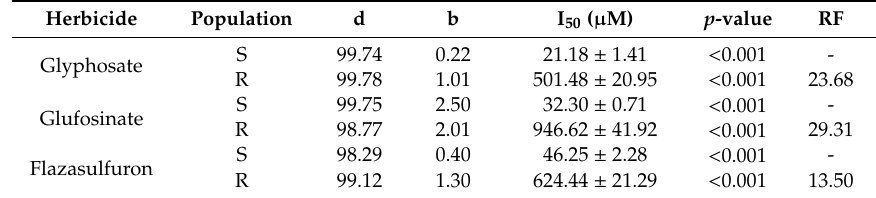
Table 4. Parameters of the log-logistic model a of the inhibition of enzymatic activity in response to herbicide concentration for R and S P. hysterophorus